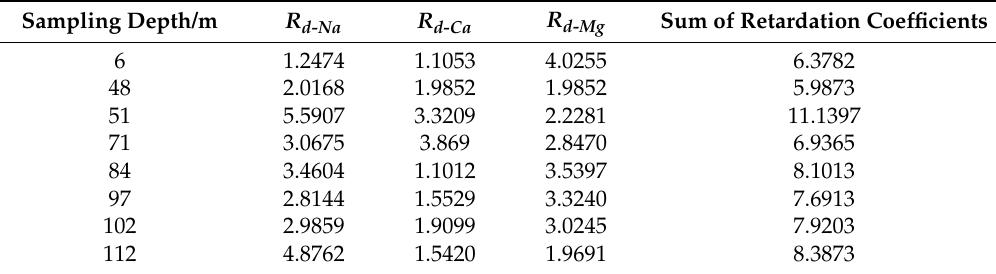
Table 7. The retardation coefficient of clay for Na + , Ca 2+ and Mg 2+ in groundwater. Sampling Depth/m R d-Na R d-Ca R d-Mg